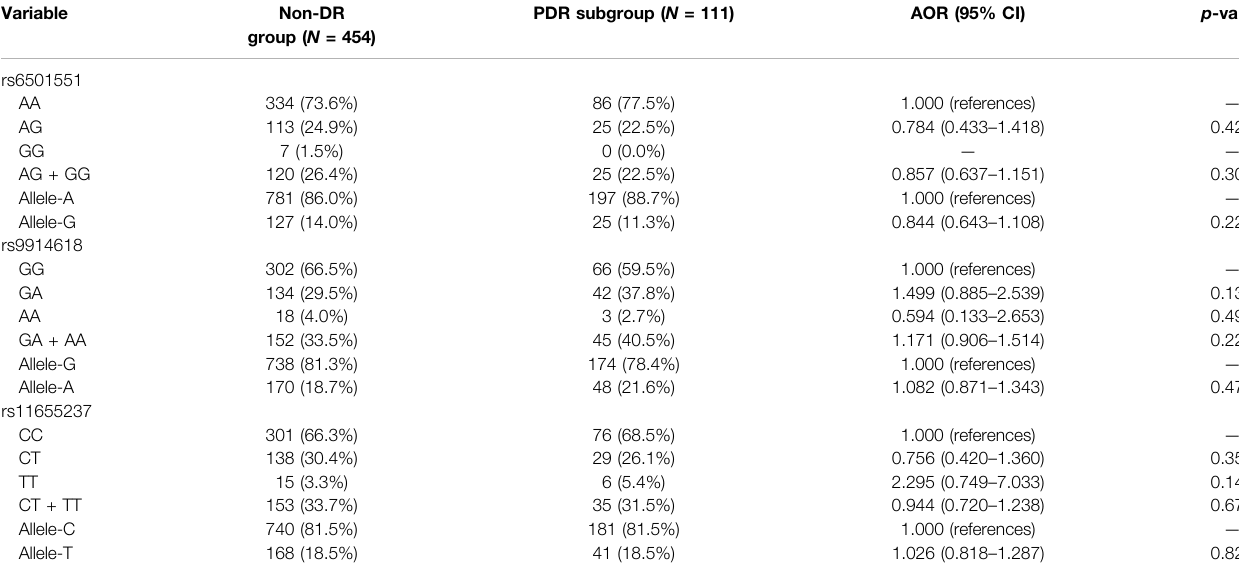
TABLE 4 | Adjusted odds ratio and 95% con fi dence intervals of proliferative diabetic retinopathy associated with LINC00673 genotypic frequencies.